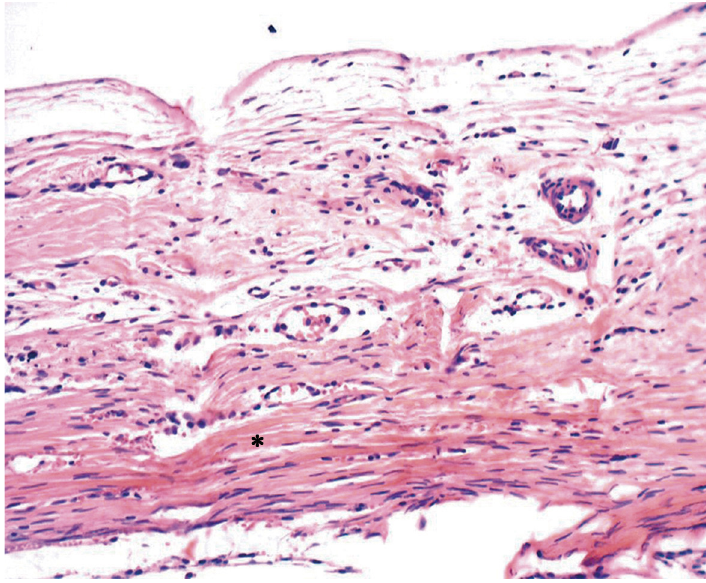
Figure 2- Group C: Presence of loose connective tissue with parallel collagen fibers and few inflammatory cells (*)